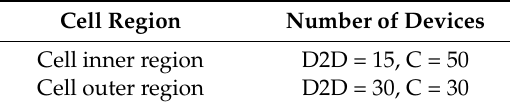
Table 2. Scenario 3 and 4: C > D2D.